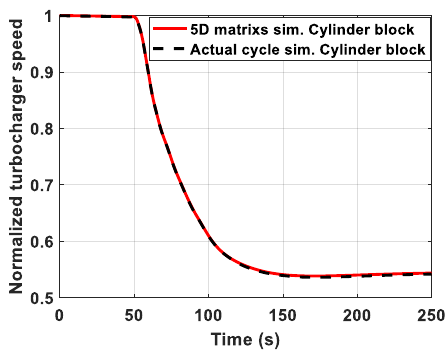
Figure 28. TC speed time history.